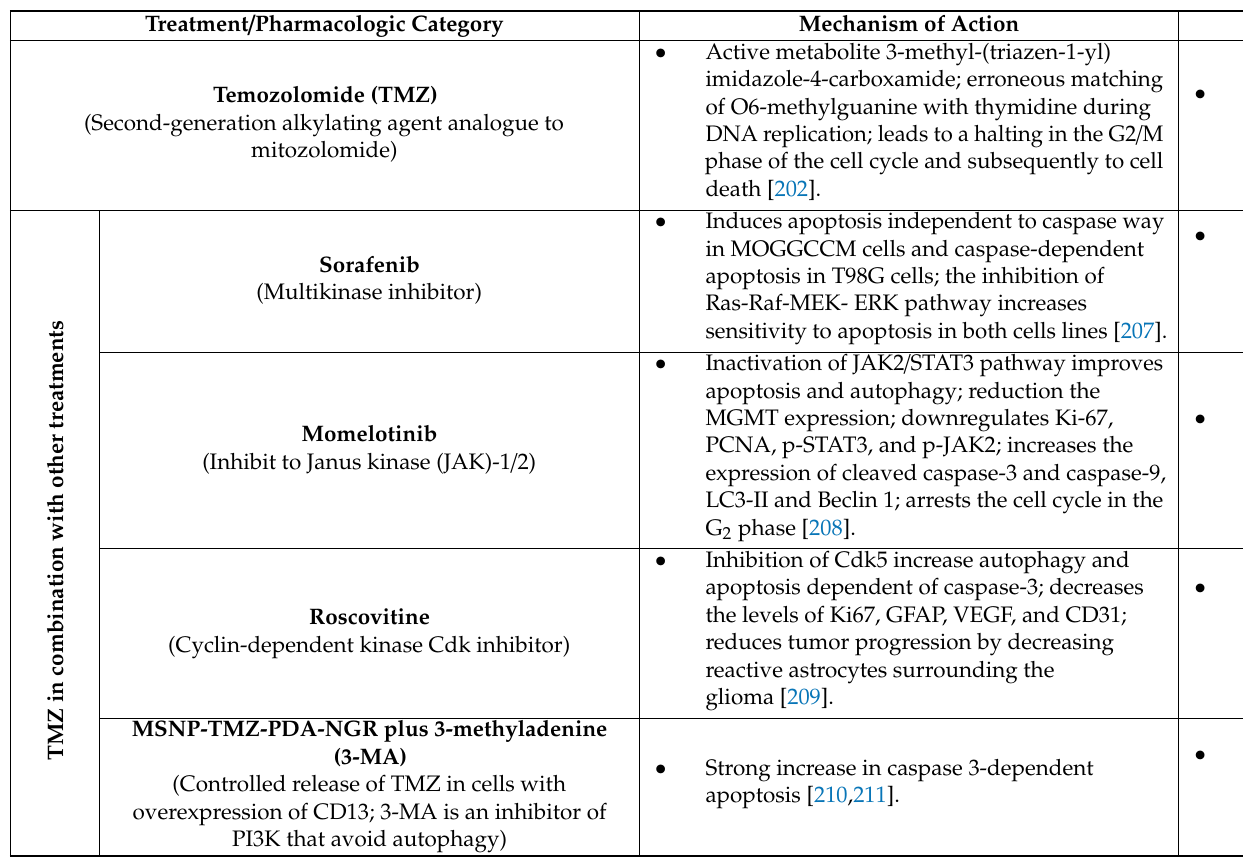
Table 1. E ff ect of temozolomide in